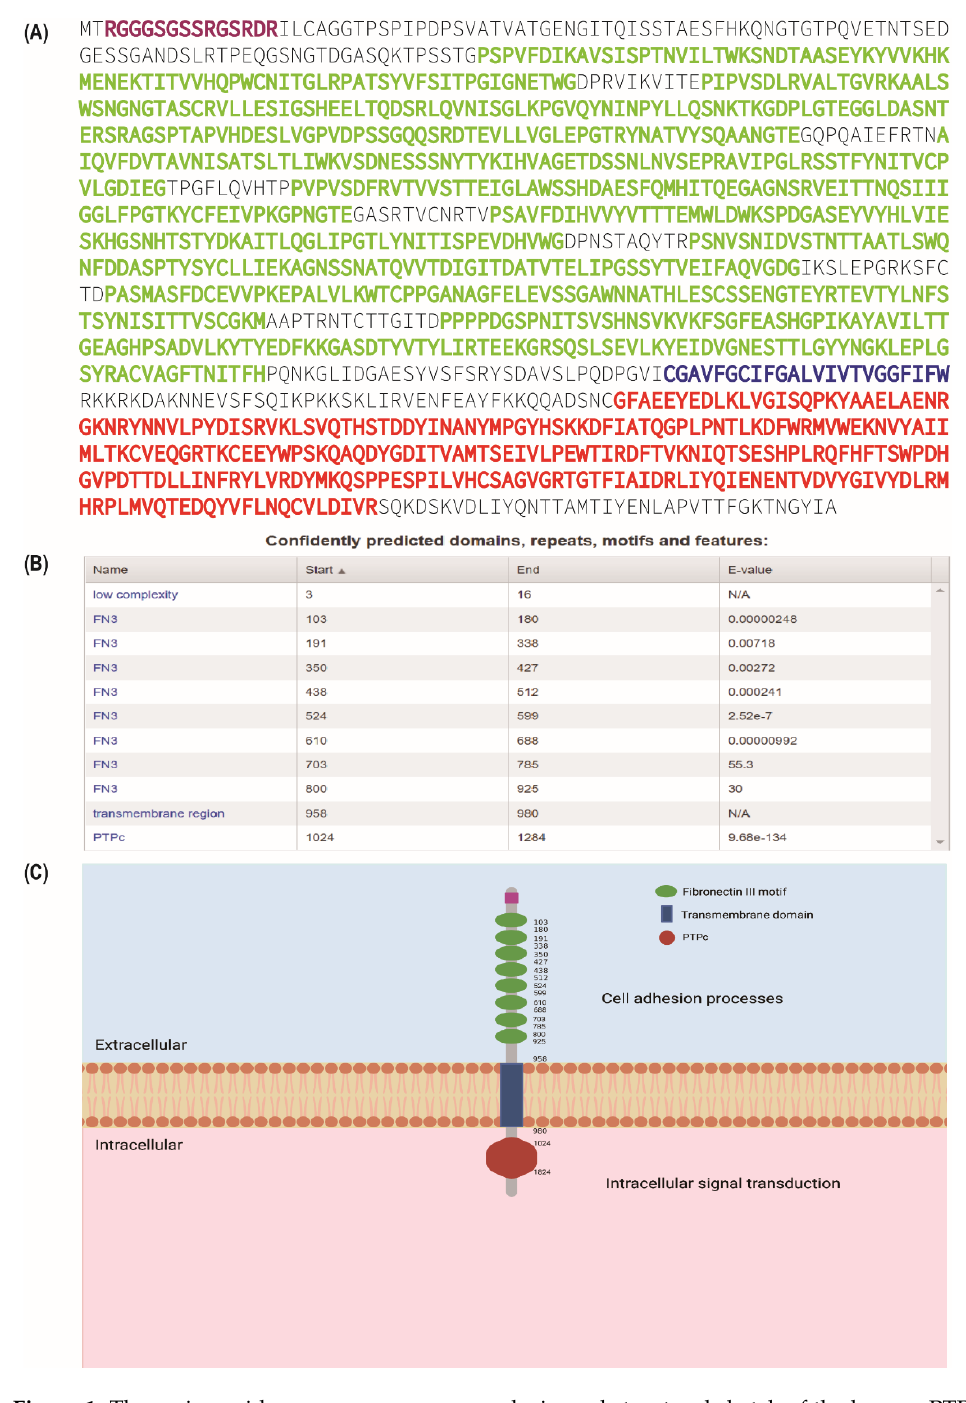
Figure 1. The amino acid sequence, sequence analysis, and structural sketch of the human PTPRJ. ( A ) The amino acid sequence of human PTPRJ was obtained from the NCBI database (http://www.ncbi.nlm.nih.gov/ accessed on December 6, 2022). The amino acid sequences of the eight fibronectin III motifs are highlighted in green, the amino acid sequence of a transmembrane domain is highlighted in dark blue, and the amino acid sequence of the intracellular phosphatase catalytic domain is highlighted in red. ( B ) The predicted domains of PTPRJ were analyzed by SMART (http://smart.embl-heidelberg.de/accessed on December 6, 2022). ( C ) The domain architec- ture of the human PTPRJ. The figure was created using BioRender (www.biorender.com).